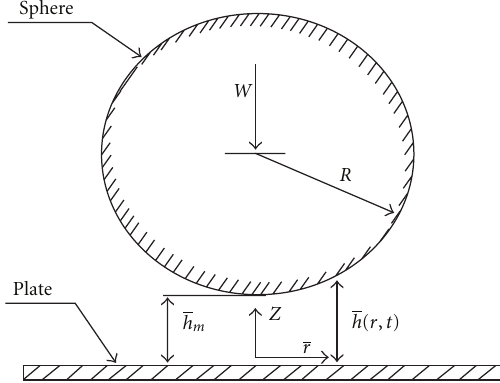
Figure 1: Schematic diagram of squeeze film between a sphere and a